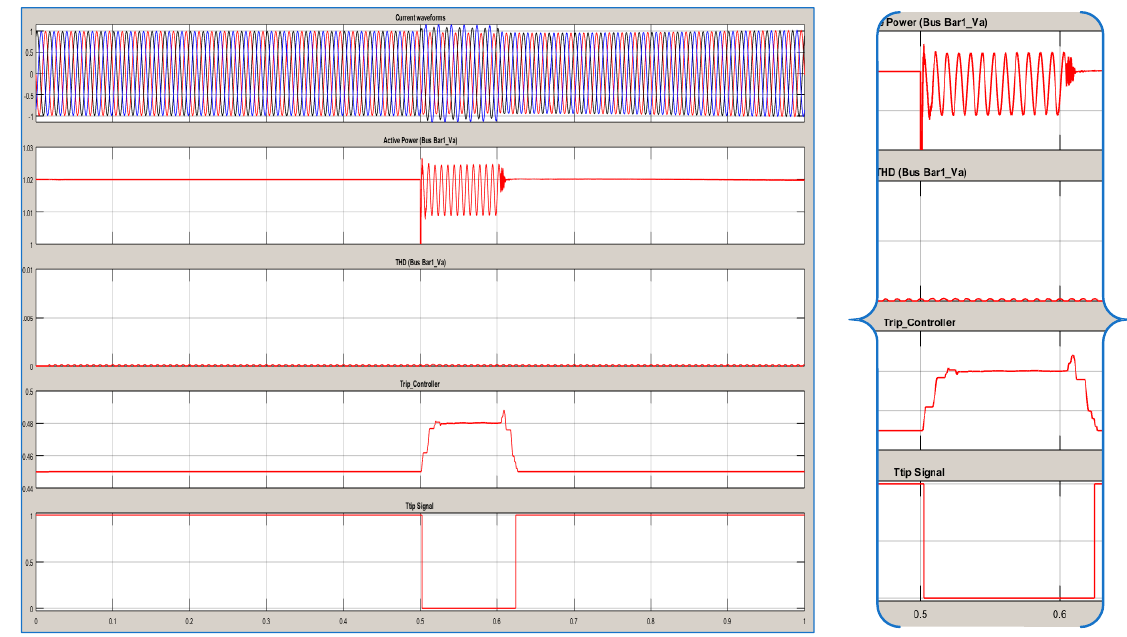
Figure 14. Single line to ground (C_G) fault current waveform.